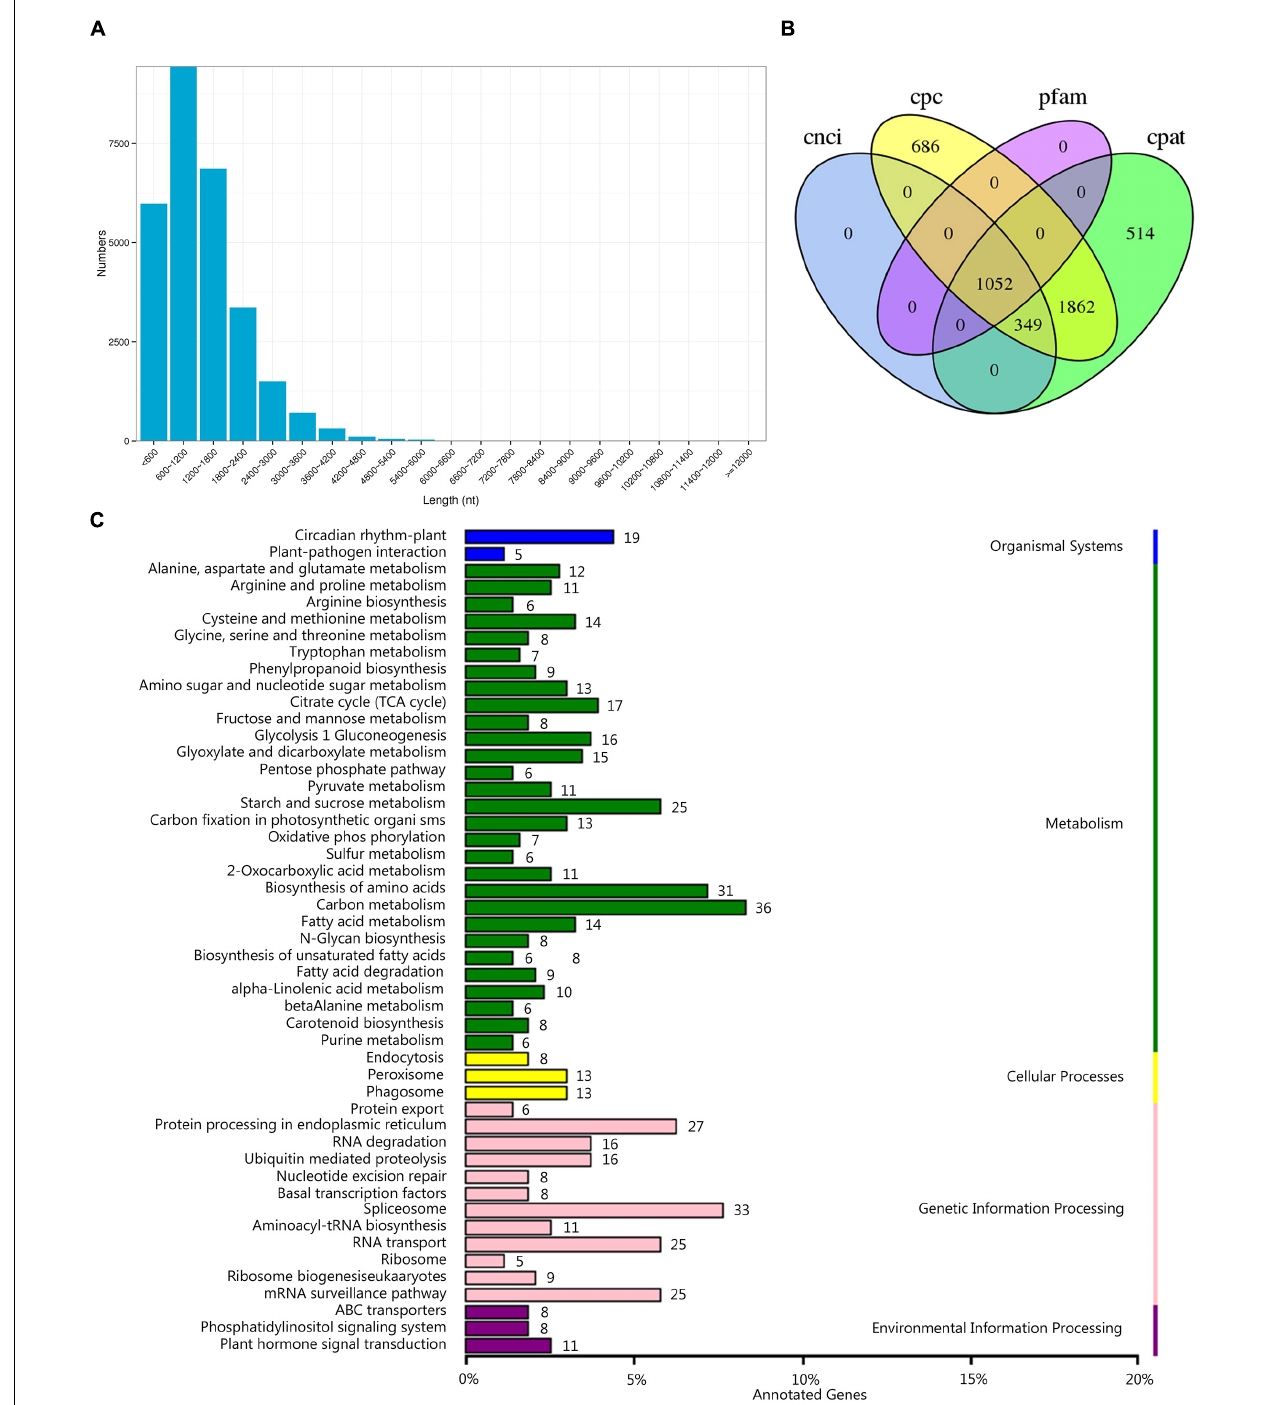
FIGURE 4 | Prediction of coding sequences (CDSs), long non-coding RNAs (lncRNAs) and alternative splicing (AS). (A) Distribution of CDSs with a complete open reading frame. (B) Venn diagram of the number of lncRNAs predicted. Cpc: coding potential calculator, cnci: coding-non-coding index, Pfam: Pfam protein domain, cpat: coding potential assessment. (C) Kyoto Encyclopedia of genes and genomes pathways of genes related to AS. Value to the right of the bar indicates the number of transcripts involved in the metabolic pathway.